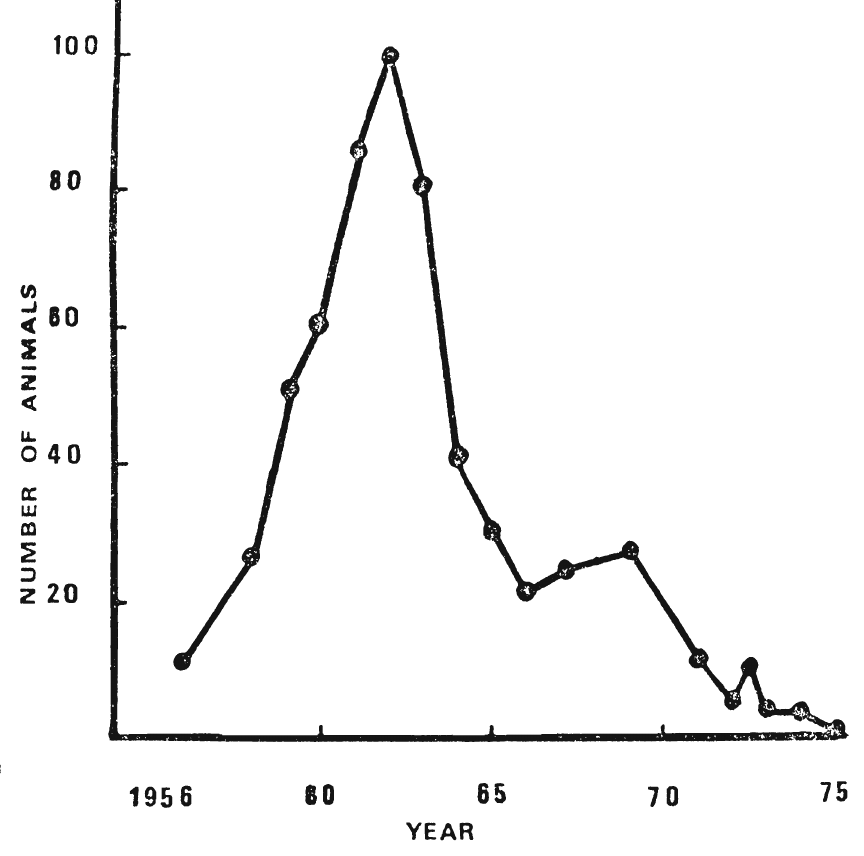
Fig. 2. Populatio n history of springbok Antidorc(lJ marsupialis m the Addo Elephant National Park,